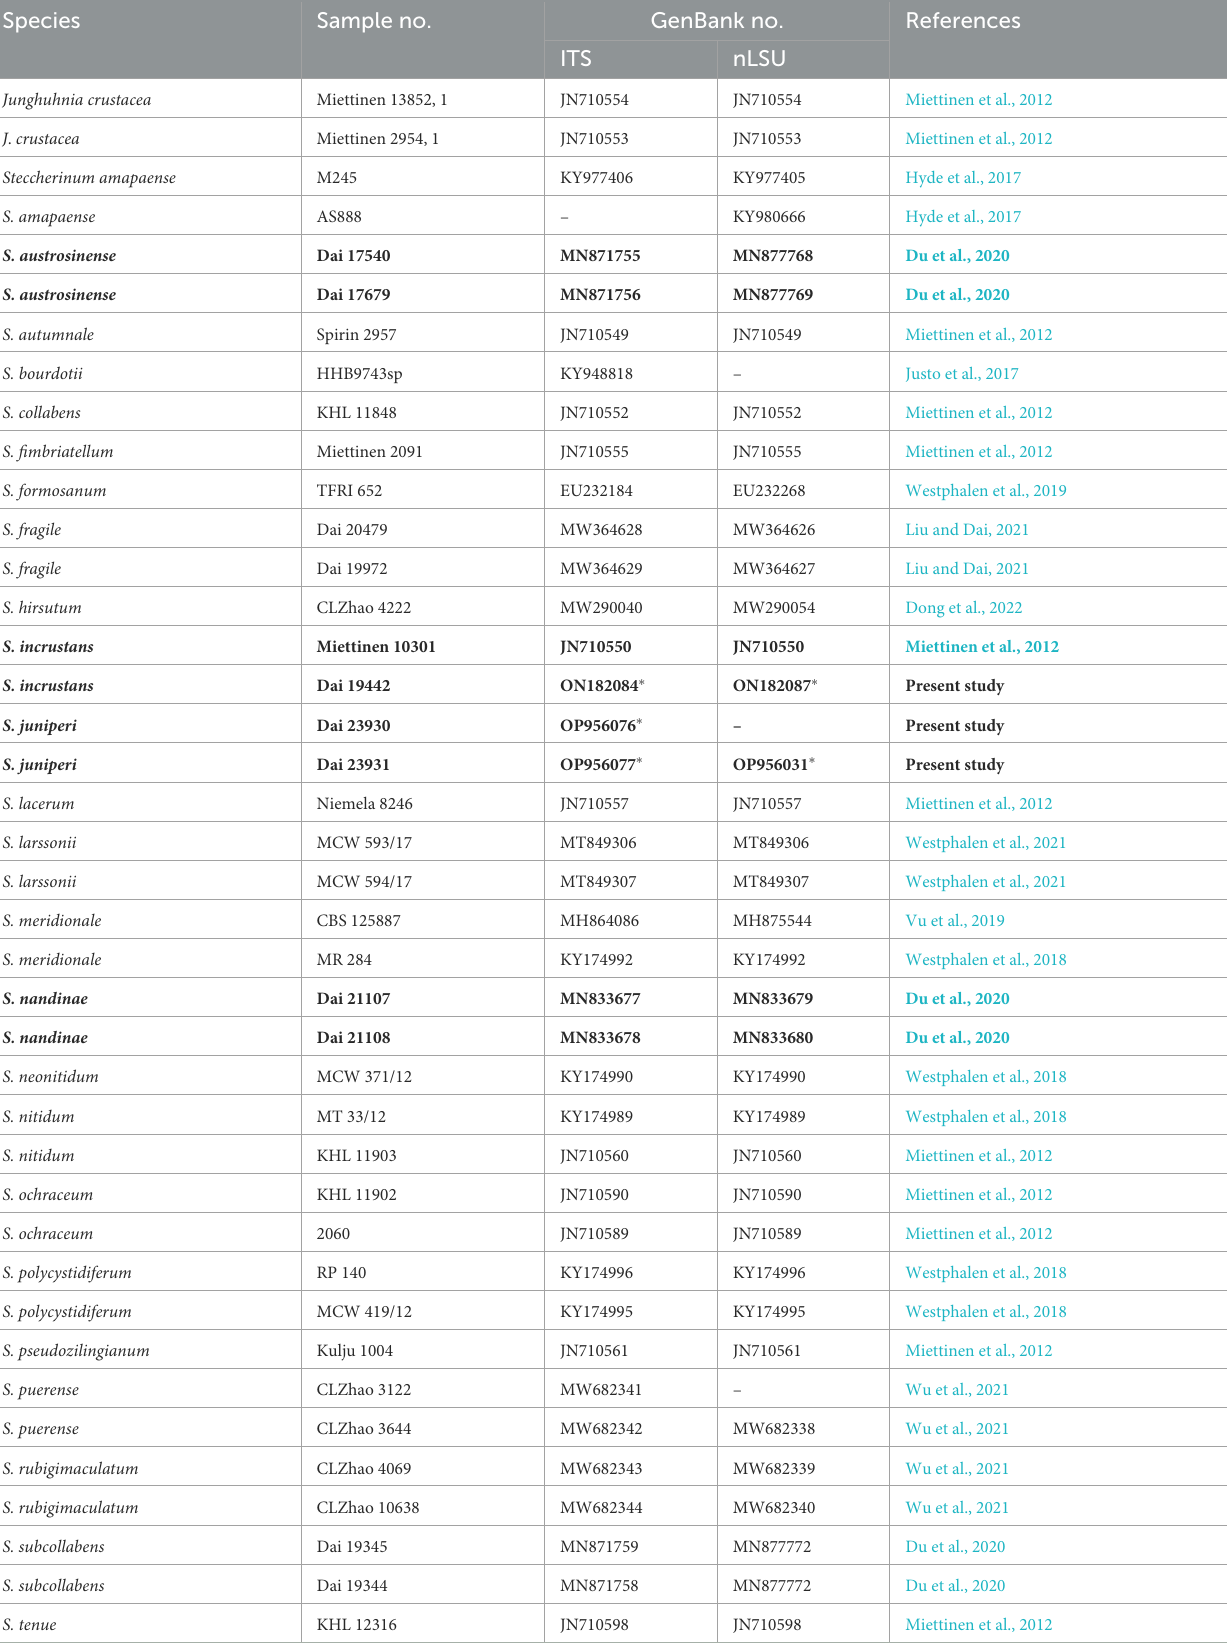
TABLE 1 List of species, specimens, and GenBank accession numbers of the sequences used in this study. Species Sample